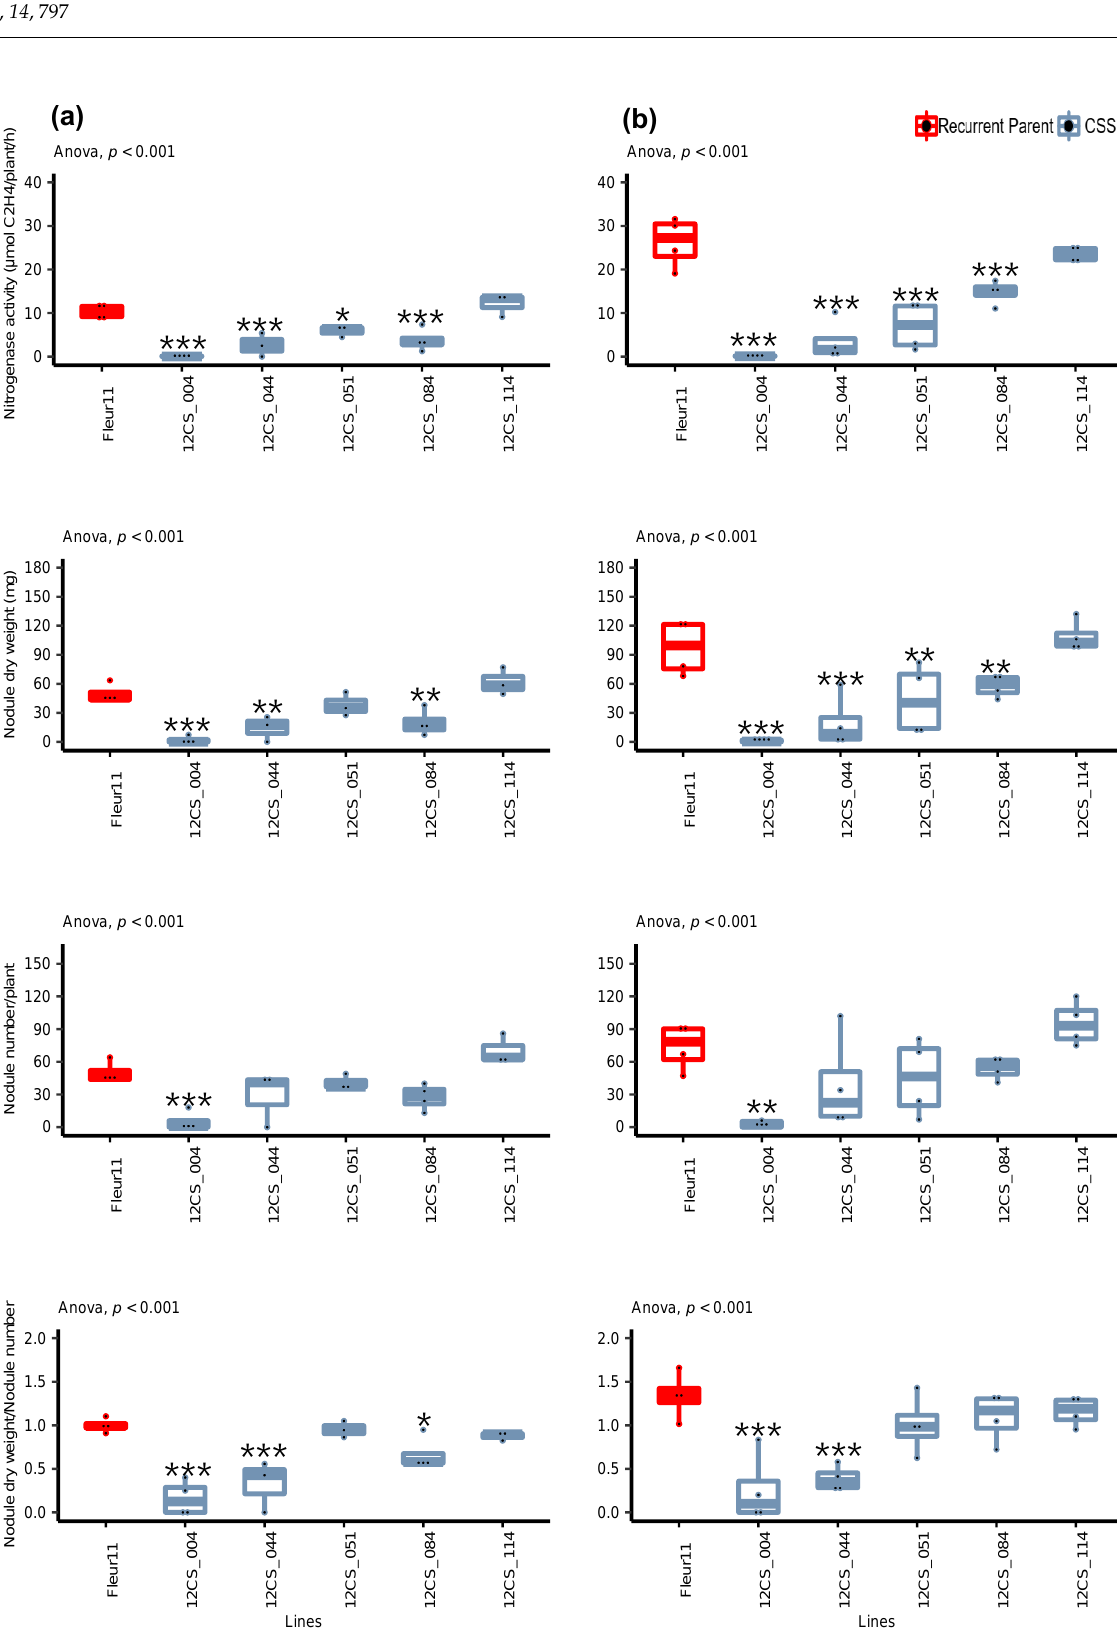
Figure 4. Significant line × trait of nodulation traits 35 days after inoculation between 5 CSSLs and the recurrent parent Fleur11. ( a , b ): First and second experiments, respectively. *, **, and *** indicate values significant at p < 0.05, p < 0.01, and p < 0.001, respectively, using Dunnett’s multiple comparisons